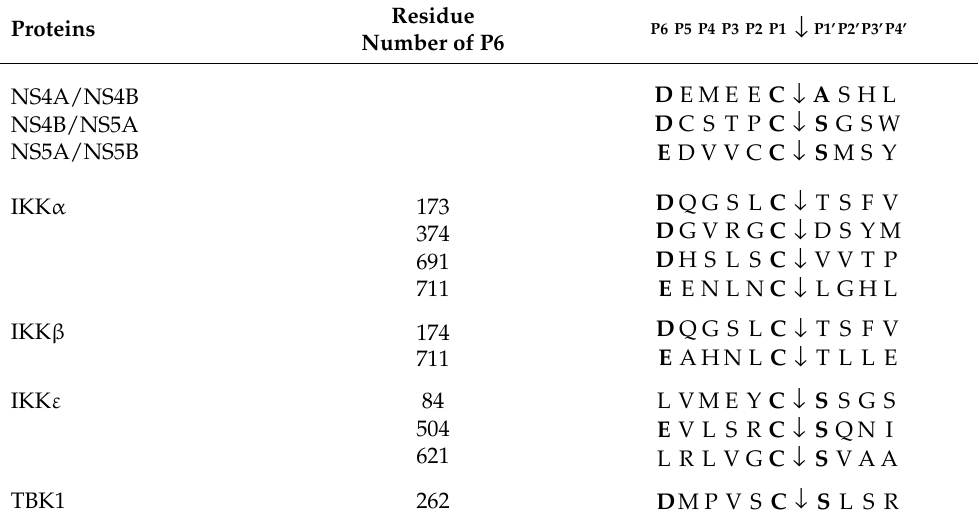
Table 1. Sequence alignment of known NS3/NS4A cleavage sites on HCV polyprotein precursor and putative NS3/NS4A cleavage sites on IKK α , IKK β , IKK ε , and TBK1. The conserved residues are in bold-face and the arrows depict the cleavage sites. Residue Proteins Number of